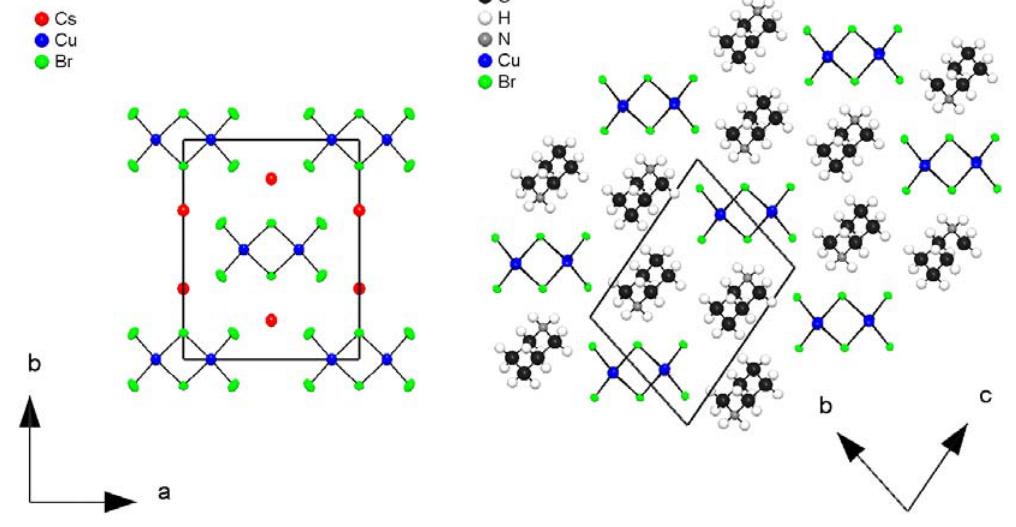
Br ] − ladders of CsCu 2 3